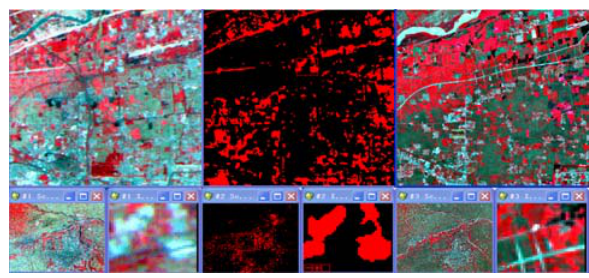
Fig.11 Increased man-made area of change detection